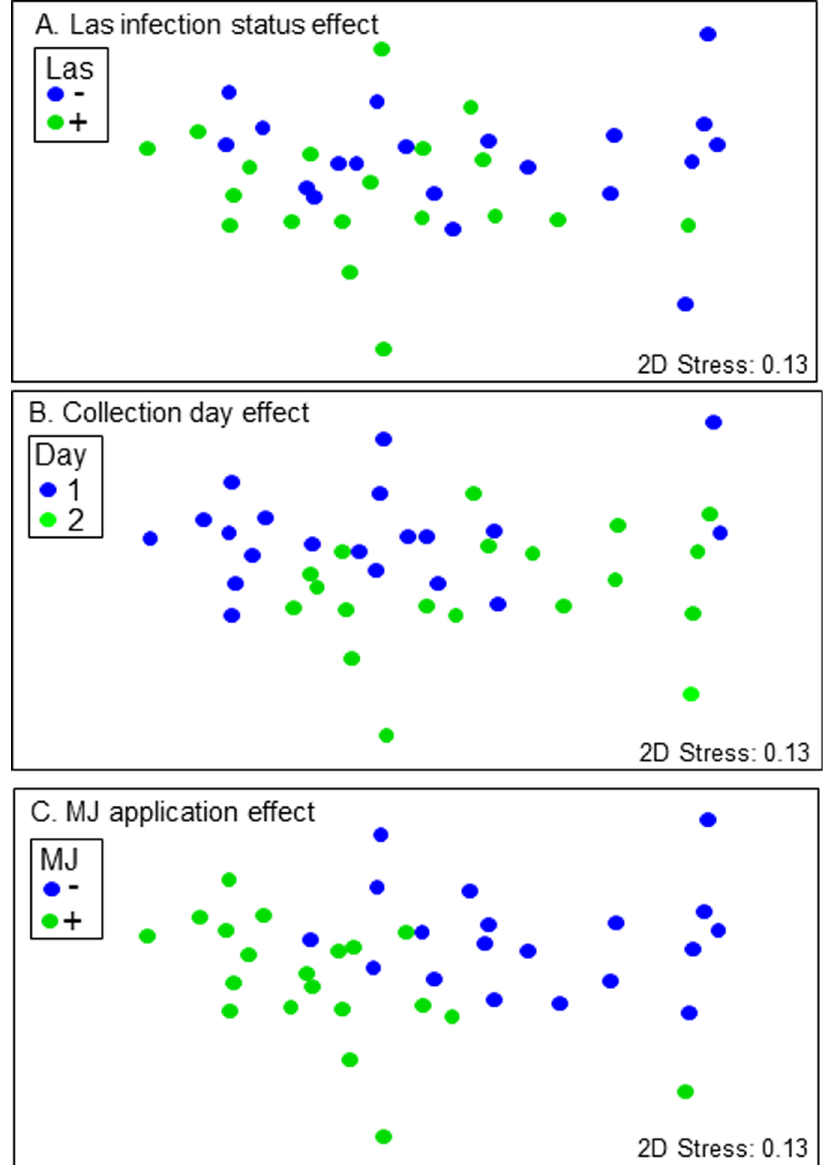
Fig 1. Nonmetric multidimensional scaling (NMDS) of the main effects on proportions of emitted volatile compounds in the MJ experiments. NMDS plots showing the effects of (A) Las infection status, (B) MJ application, and (C) collection day on the proportions of volatiles emitted. Comparisons of the proportions of volatile compounds in each treatment were based on Bray-Curtis similarities plotted in a non-metric multidimensional scaling. class proportionality (Las infection status: ANOSIM global R = 0.317, P (cid:20) 0.004); collection day: ANOSIM global R = 0.258, P (cid:20) 0.002), whereas MJ treatment had a very strong effect (ANO- SIM global R = 0.674, P (cid:20) 0.0001). Similarity of percentages analysis (SIMPER) showed that alkyl aldehydes, monoterpenes, and sesquiterpenes were the main contributors to the observed variation between treatments (alkyl aldehydes: 27.96%; monoterpenes: 22.07%; sesquiterpenes: 20.97%) (Fig 2 ) The proportional changes in nitrogen-based compounds reflected those ob- served in indole and contributed 15.12%. Methyl salicylate, the primary aromatic compound,